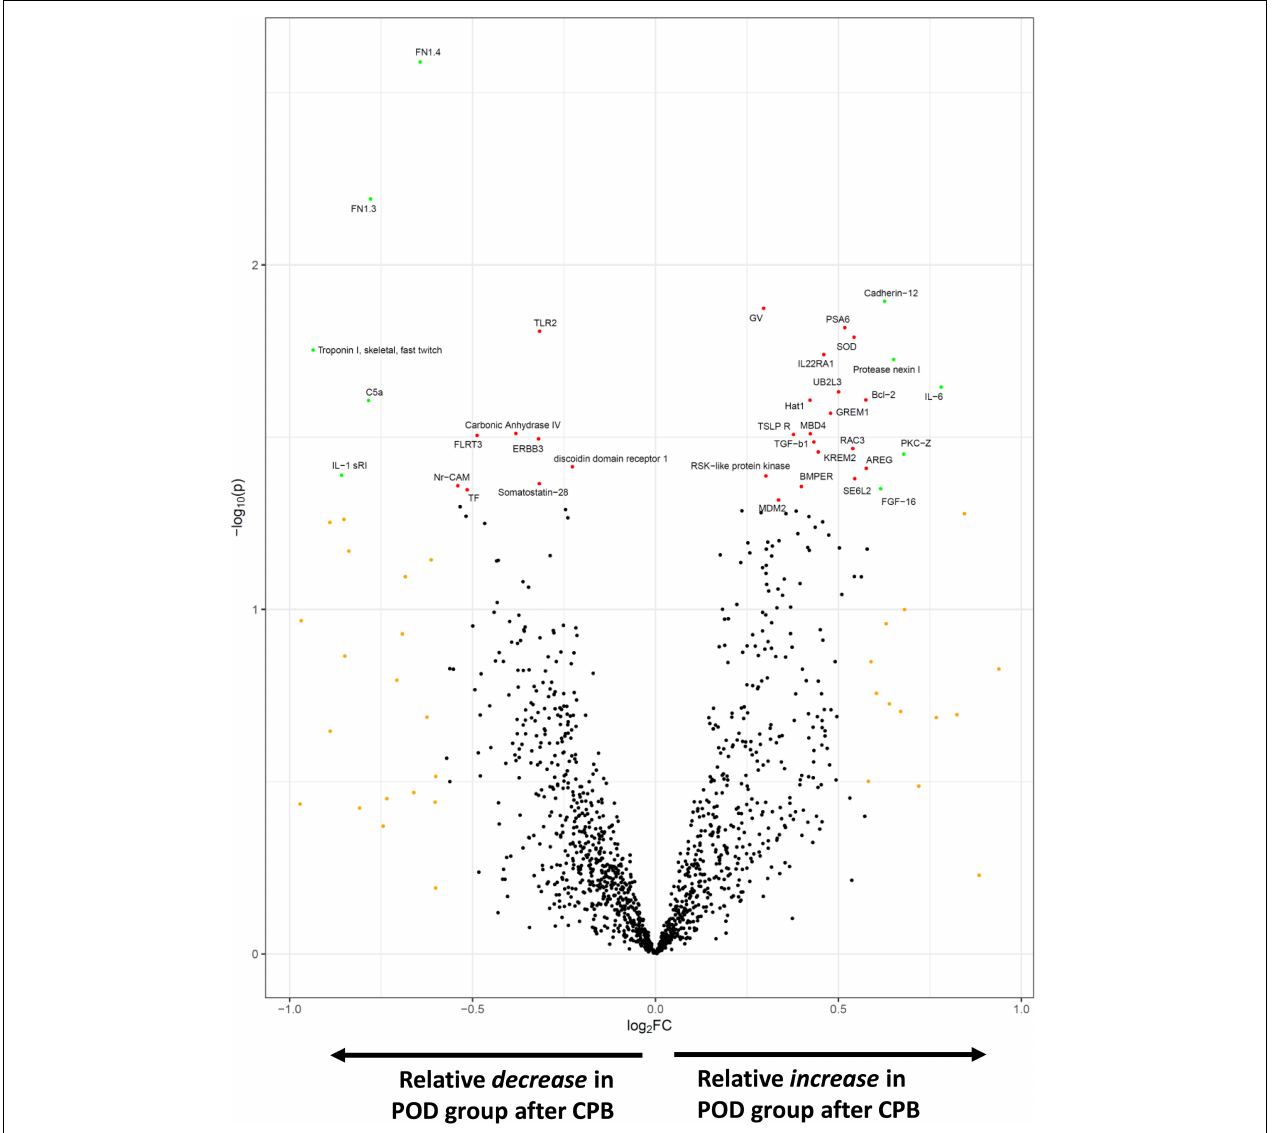
FIGURE 4 | SOMAscan proteins associated with delirium. The volcano plot shows those proteins most differentially changed during surgery in the POD vs. non-POD groups. Fold change (FC) is calculated by (postoperative/preoperative level) PODgroup ÷ (postoperative/preoperative level) non − PODgroup . Those proteins in orange satisfied absFC > 1.5, red achieved p -value < 0.05, and green met both p -value and FC